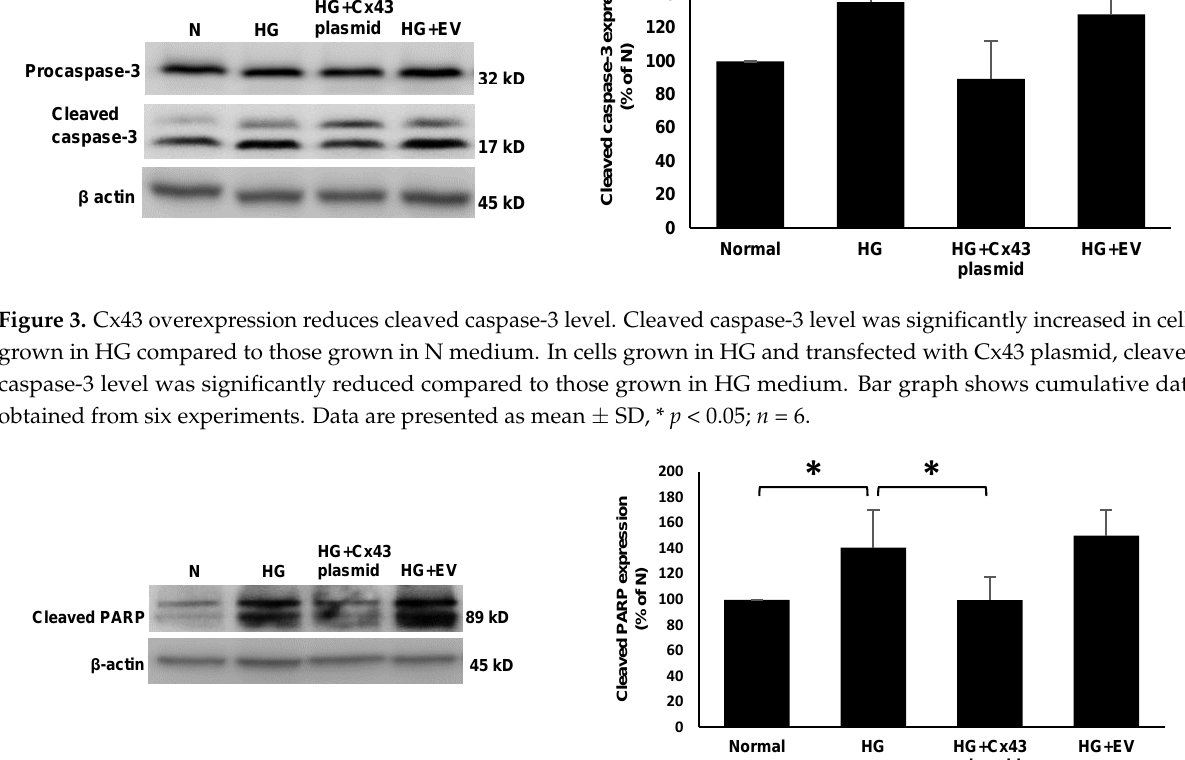
Figure 4. Cx43 overexpression reduces cleaved PARP level. Cleaved PARP level was significantly increased in cells grown in HG compared to those grown in N medium. In cells grown in HG and transfected with Cx43 plasmid, cleaved PARP level was significantly decreased compared to cells grown in HG medium. Bar graph shows cumulative data obtained from six experiments. Data are presented as mean ± SD, * p < 0.05; n =